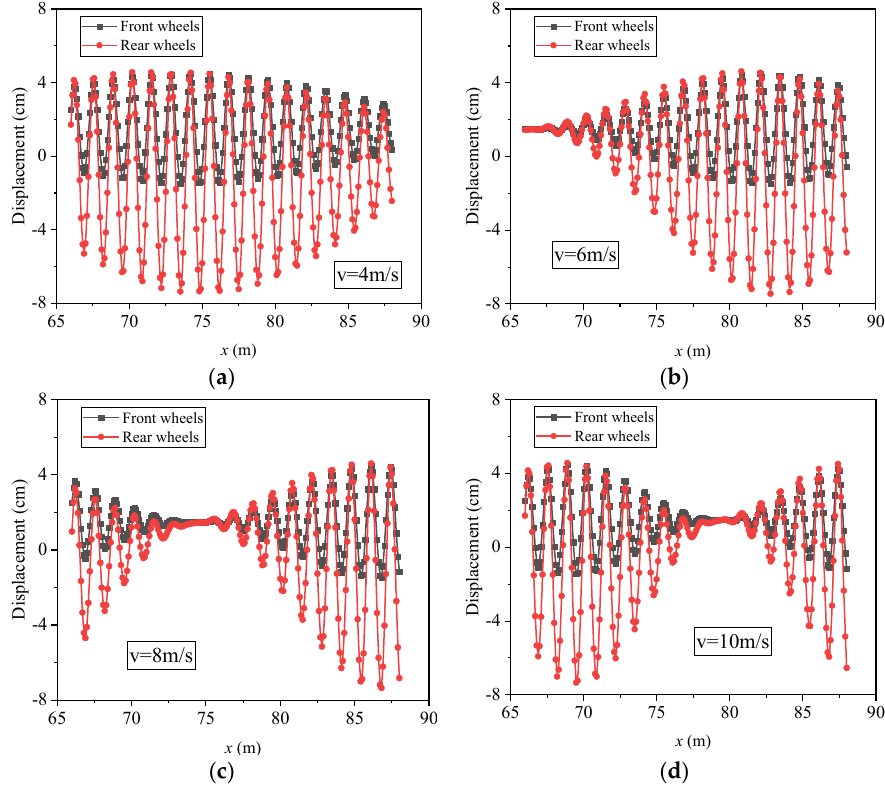
Figure 12. Net displacement of front and rear wheels 2 ns ≤ x ≤ 2 ns + ( b + c ) ( n ∈ N* ): ( a ) v = 4 m/s; ( b ) 6 m/s; ( c ) 8 m/s; ( d ) 10 m/s.